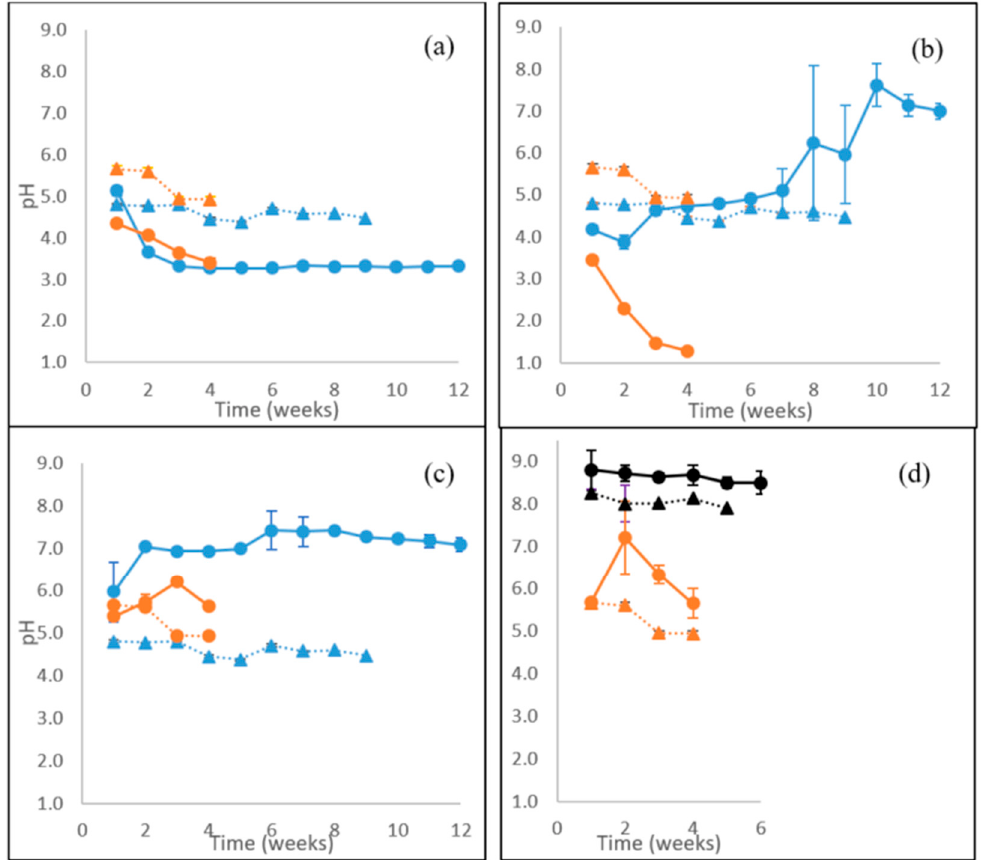
Figure 6. pH values recorded during 12 weeks of lignocellulose solid-state cultivations and 4 weeks on ME liquid medium, cultures of ( a ) WR fungus P. radiata ; ( b ) BR fungus F. pinicola ; ( c ) “GR” fungus S. commune ; ( d ) LDF C. cinerea . Fungal cultivations were performed on birch wood (blue line with spheres) or barley straw (black line with spheres), and on liquid ME medium (orange line with spheres). Values from control incubations of birch wood (blue triangles, dotted line), barley straw (black triangles, dotted line) and liquid ME medium (orange triangles, dotted line) without fungi are included. Mean value ( n = 3) is presented at each week time point. Bars indicate the standard error.